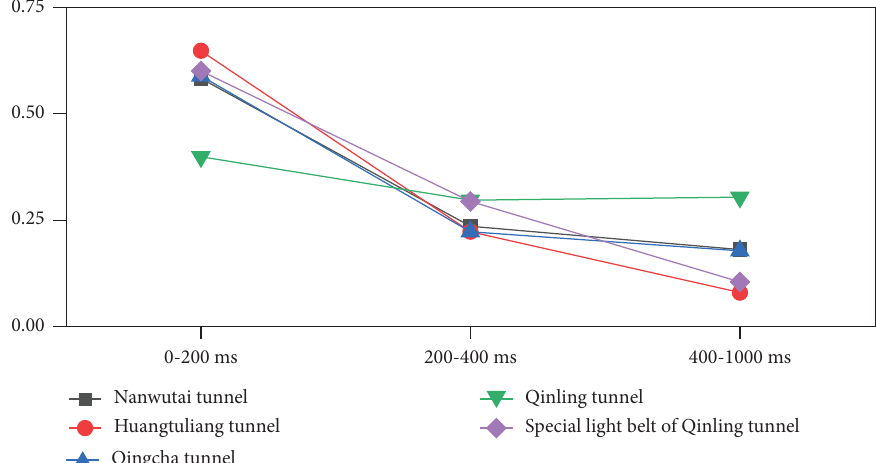
Figure 8: Proportion of drivers’ diferent fxation duration in interior zone of each